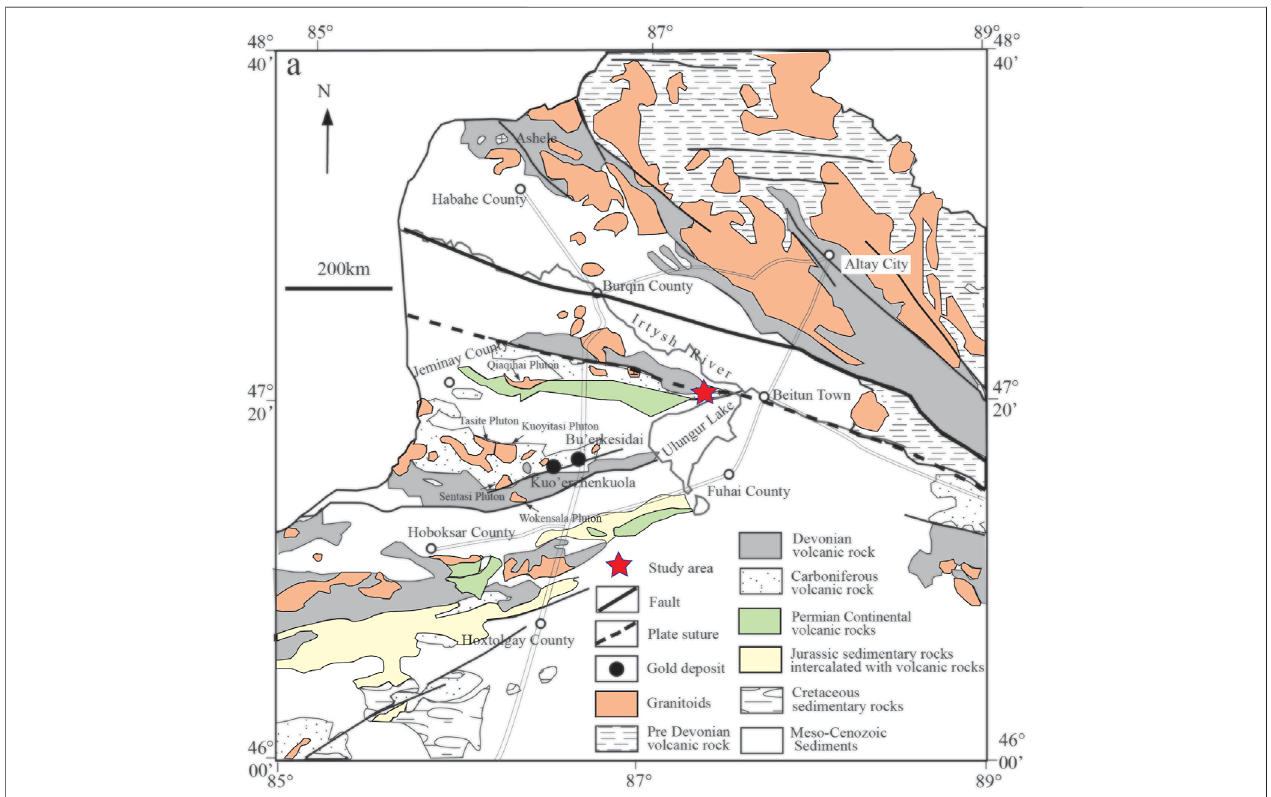
FIGURE 1 | Regional geological map of Sawur and adjacent regions (modi fi ed after He et al., 2005).